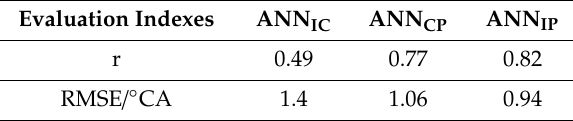
Table 4. Prediction performance of three ANN